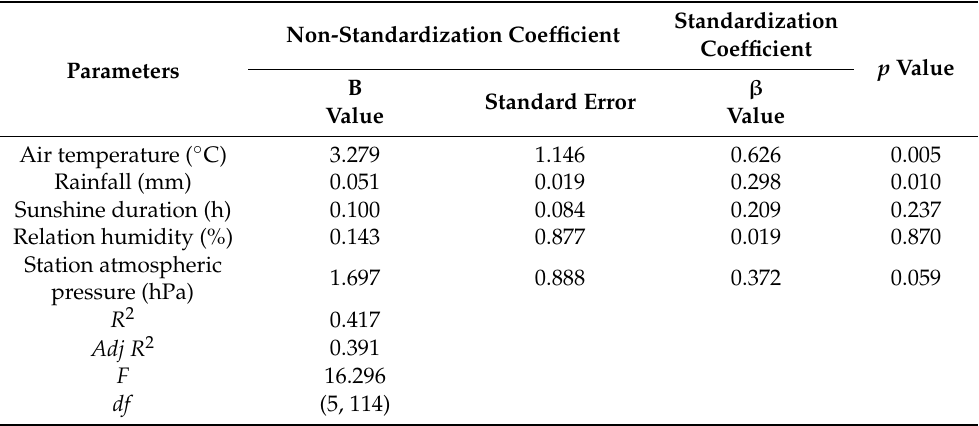
Table 5. Association between confirmed cases and climate factors from a survey of patients with scrub typhus and climate factors between 2010 and 2019 in Taiwan.